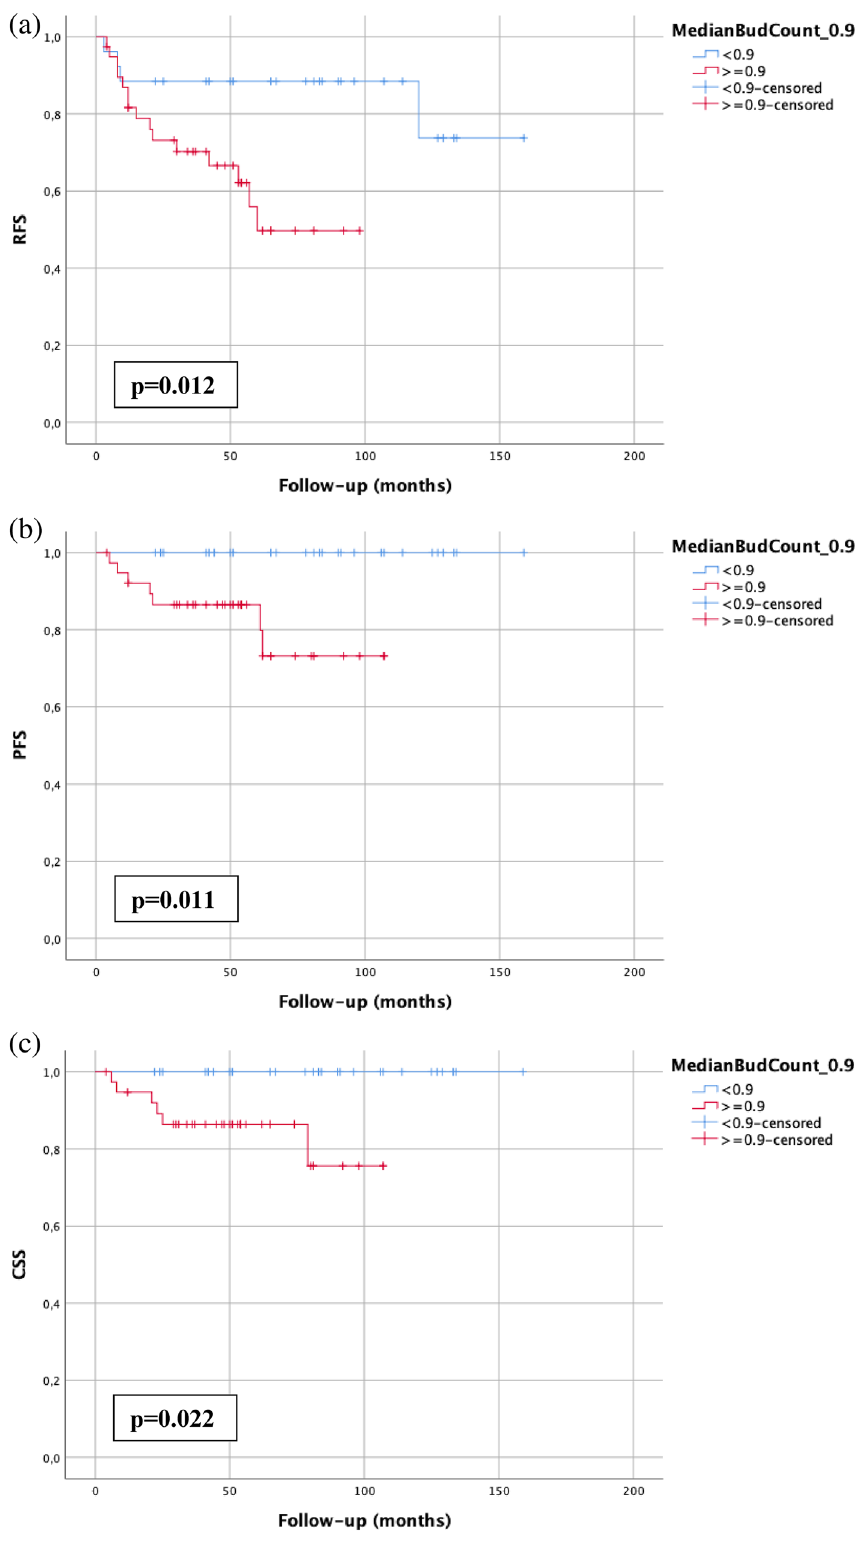
Figure 3. Kaplan–Meier analysis of tumor budding (cutoff: 0.9) in BCG-treated patients (n = 65) regarding RFS ( a ), PFS ( b ) and CSS ( c ). A p value < 0.05 indicates significant